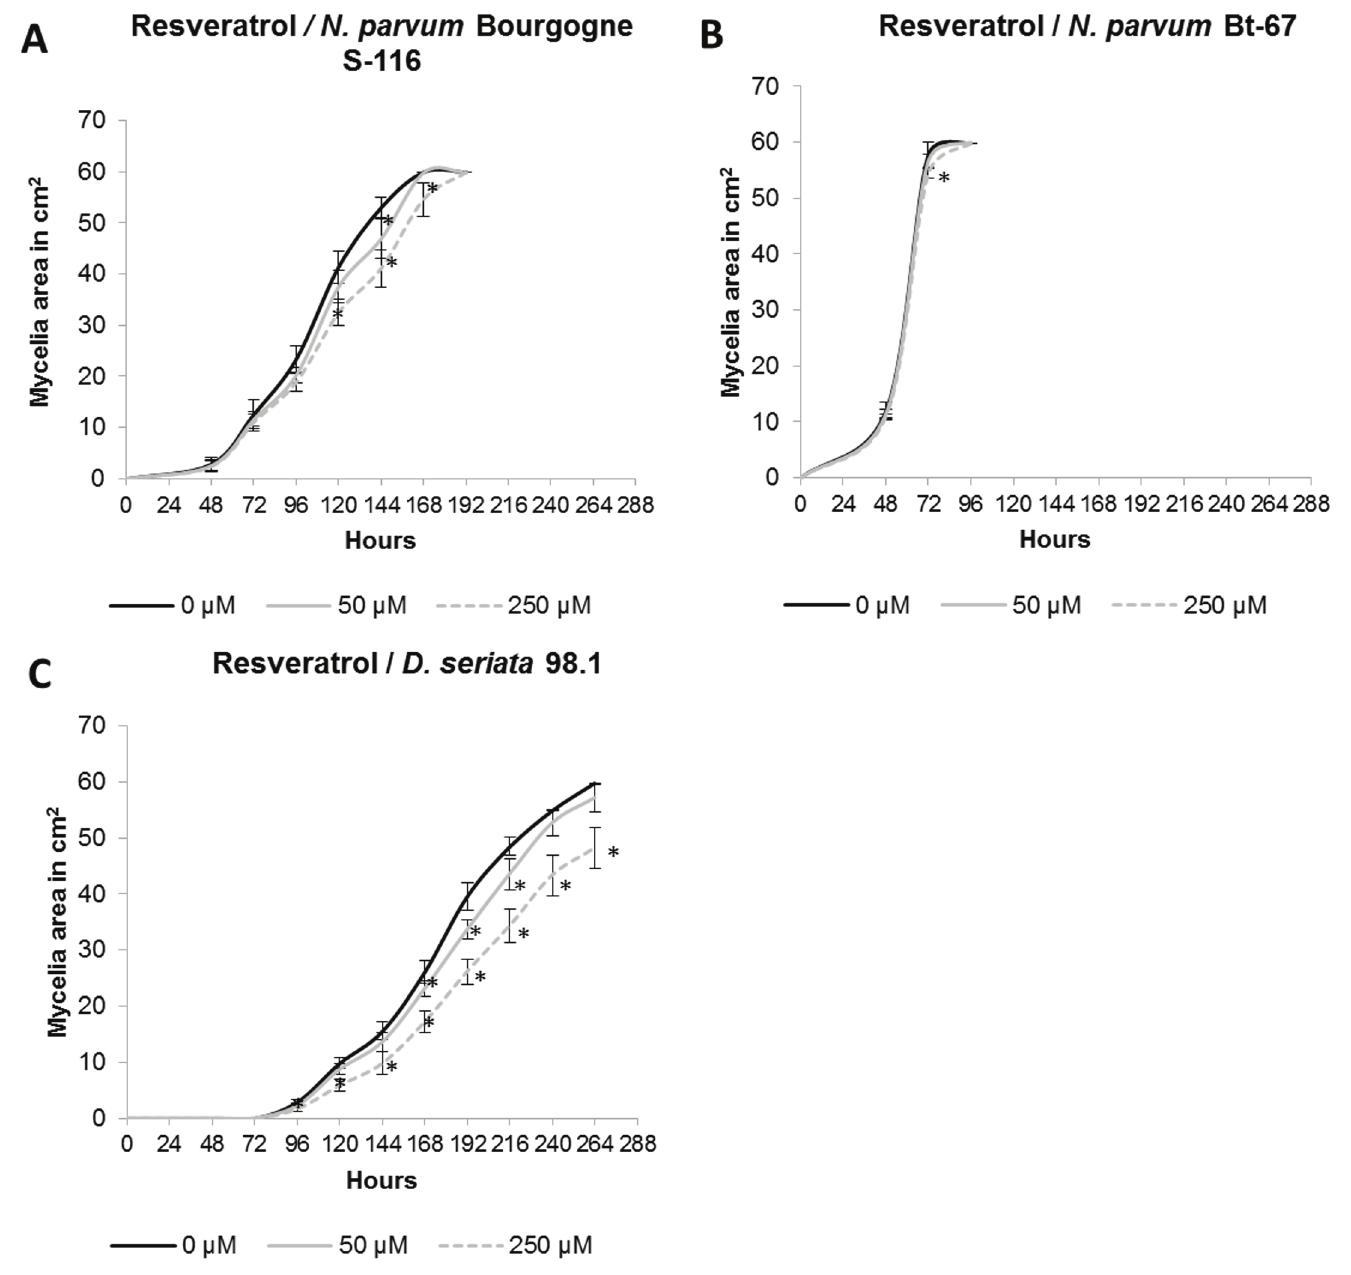
Fig 4. Effect of resveratrol on Botryosphaeriaceae . The resveratrol was tested at a final concentration of 50 μ M (grey lines) and 250 μ M (gray dotted lines) on mycelialgrowth of N . parvum BourgogneS-116 (A), N . parvum Bt-67 (B) and D . seriata 98.1 (C). Negativecontrol was performed by addingDMSO insteadof resveratrol. Values are means and SD of two biological replicates,each calculatedfrom the mean of three technicalreplicates. Means with a * are significantly different from control at p (cid:20) 0,05 (Tukey